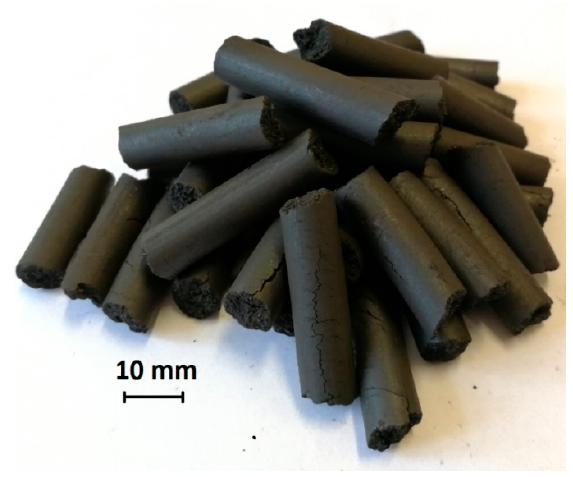
Figure 3. General view of briquettes produced.